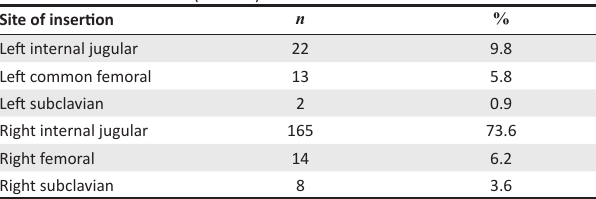
TABLE 2: Site of insertion ( n = 224).